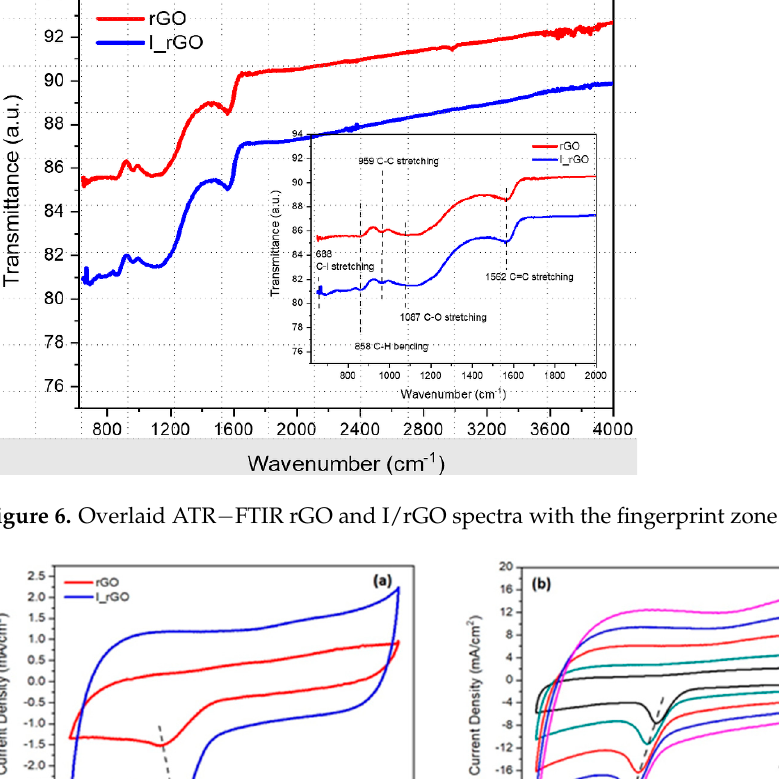
Figure 5. TGA/DTGA plots corresponding to: ( a ) r − GO and ( b ) I/rGO.